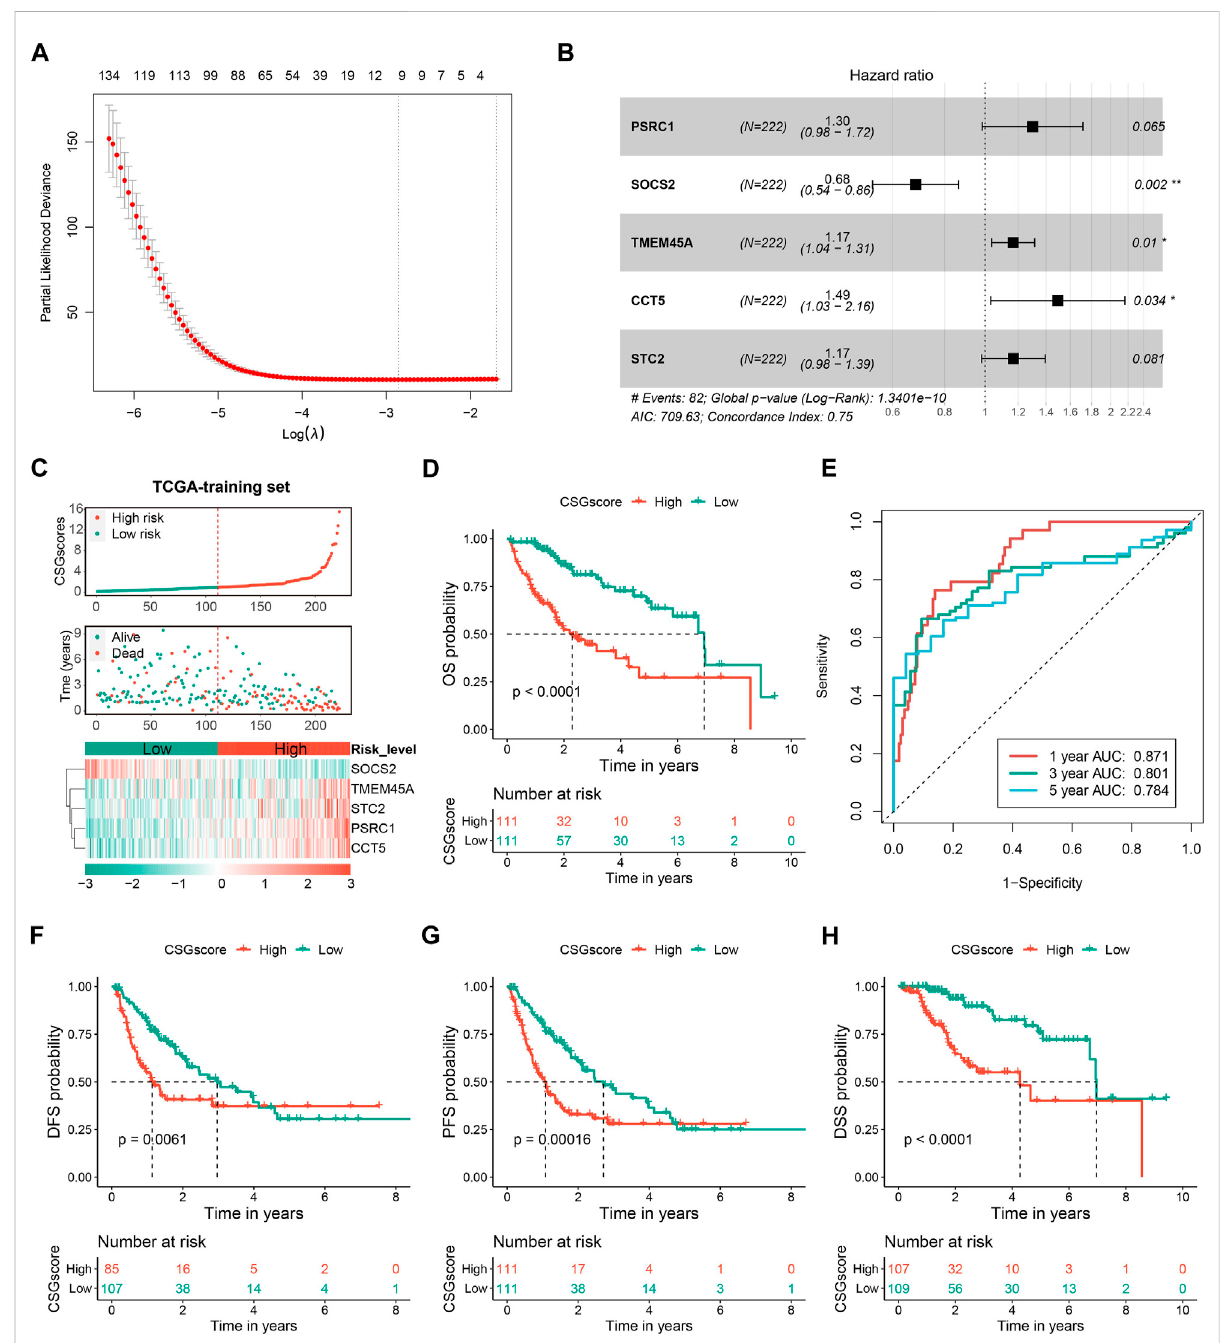
FIGURE 5 Construction and evaluation of the CSGs scoring system (CSGscore) of HCC based on the TCGA training dataset . (A) LASSO-COX was applied to identify 10 potential genes, followed by the stepwise method to select the fi nal fi ve of them for the construction of the CSGs scoring system. (B) Forest plot showing the coef fi cients and signi fi cant levels of the fi ve CSGscore genes in the model. (C) Patients in the TCGA training set were classi fi ed into the high- and low-risk groups according to the median value of CSGscores, and (C) shows the distribution of their CSGscores, survival status, and the expression pro fi le of the fi ve CSGscore genes. (D,E) The Kaplan-Meier survival plots (D) and tROC curves (E) for the OS of CSGscore in the training dataset. (F – H) The Kaplan-Meier survival plots of CSGscore for the DFS, PFS, and DSS of